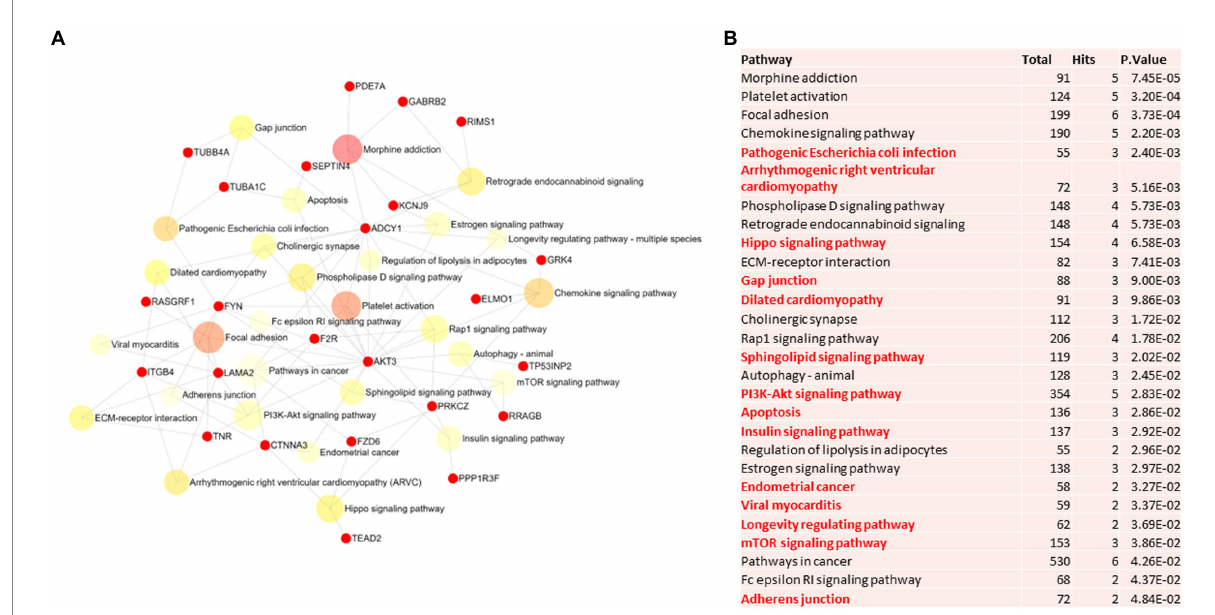
FIGURE 3 Pathway analysis of switch genes from females with Alzheimer’s disease (F-AD). (A) Biological and functional analysis of switch genes from F-AD compared to controls was performed in NetworkAnalyst. Switch genes are depicted in red. (B) The pathways are ranked according to the number of hits and lowest value of p. Pathways are derived from the KEGG database. The unique pathways are shown in